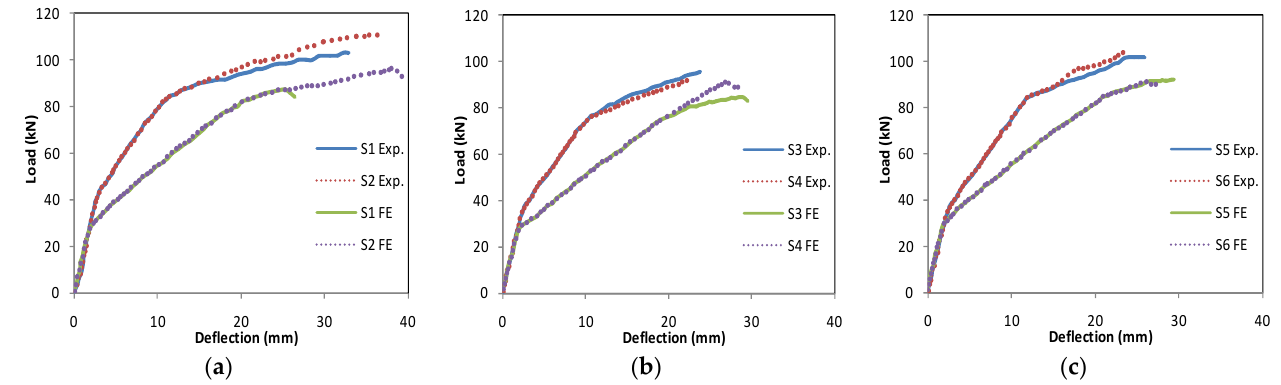
Figure 10. Load–deflection curves of experimental tests [1] and FE models: ( a ) sample S 1 , S 2 ; ( b ) sample S 3 , S 4 ; ( c ) sample S 5 , S 6 .